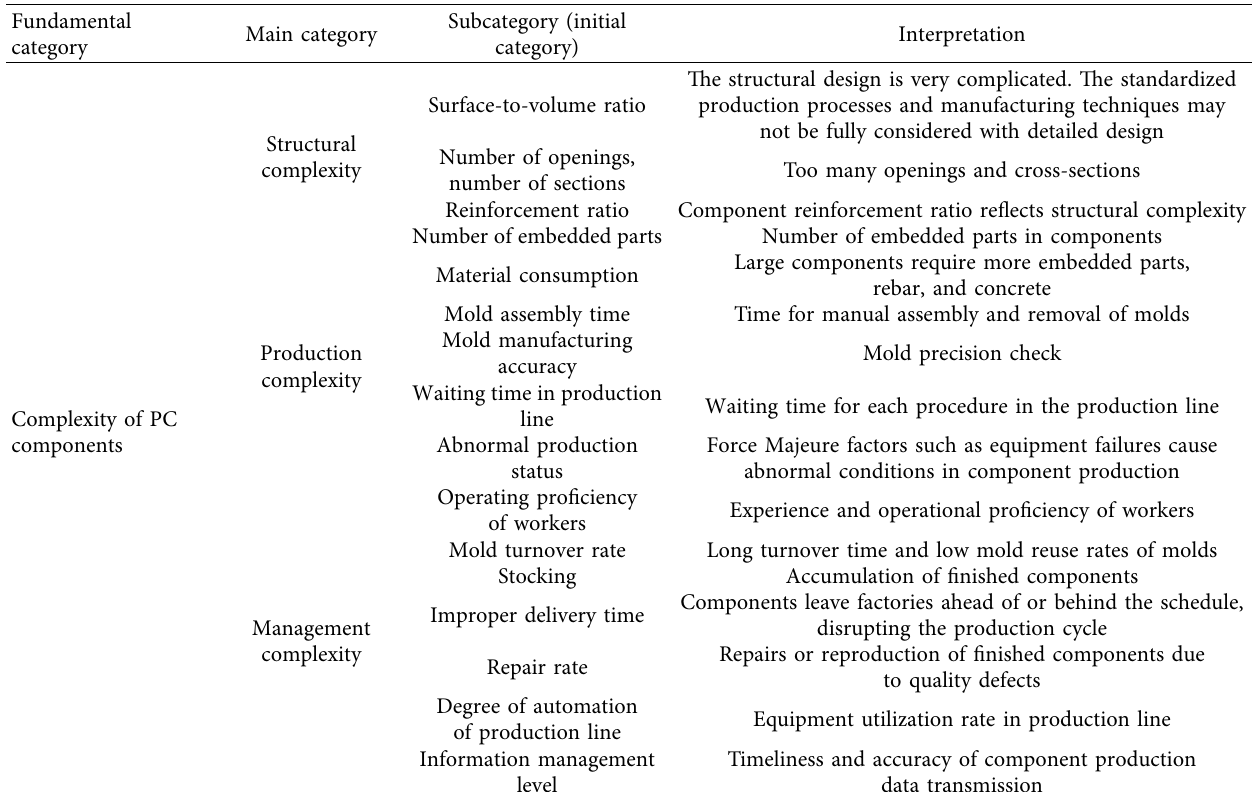
Table 3: Results of axial coding and selective